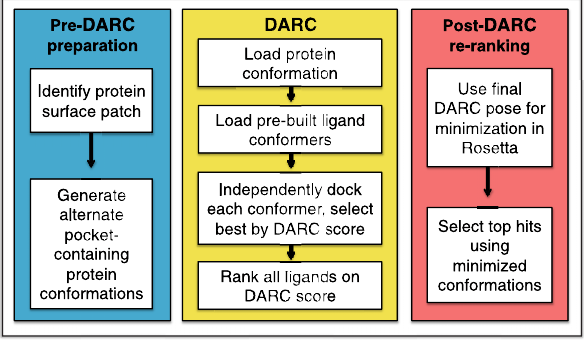
Figure 1. Docking overview. A schematic diagram of the complete workflow split into three stages: pre-DARC preparation, DARC, and post-DARC re-ranking.